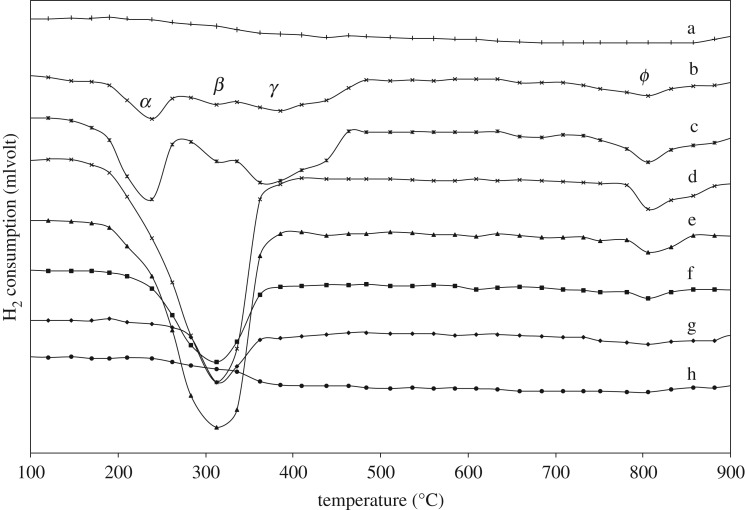
TPR of (a) CeO2, (b) CuO powder for 0 h milling and (CuO)x(CeO2)1−x powder after 18 h milling (x= (c) 1, (d) 0.8, (e) 0.5, (f) 0.3, (g) 0.2, (h) 0).